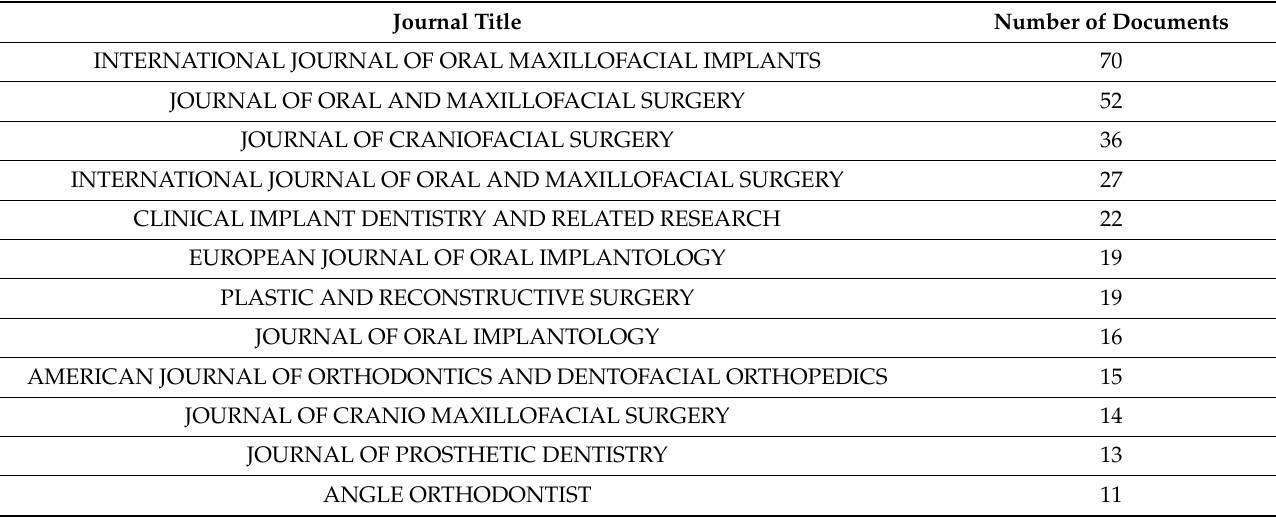
Table 3. Main Journals publishing zygomatic implants documents. The table shows the number of documents per Journal among the 20 Journals with more documents published in this issue.